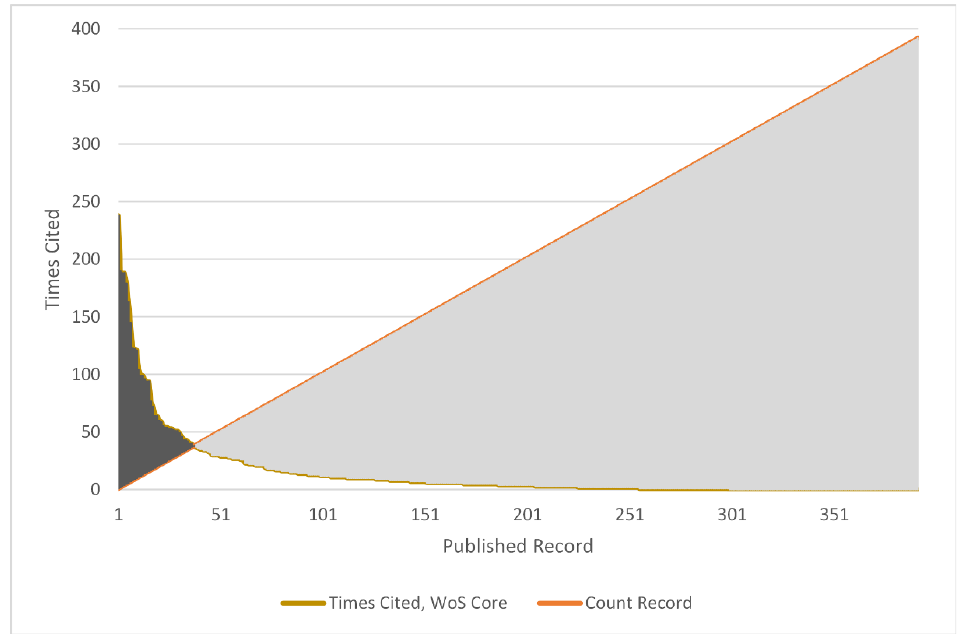
Figure 4. National/territorial co-authorship graph.